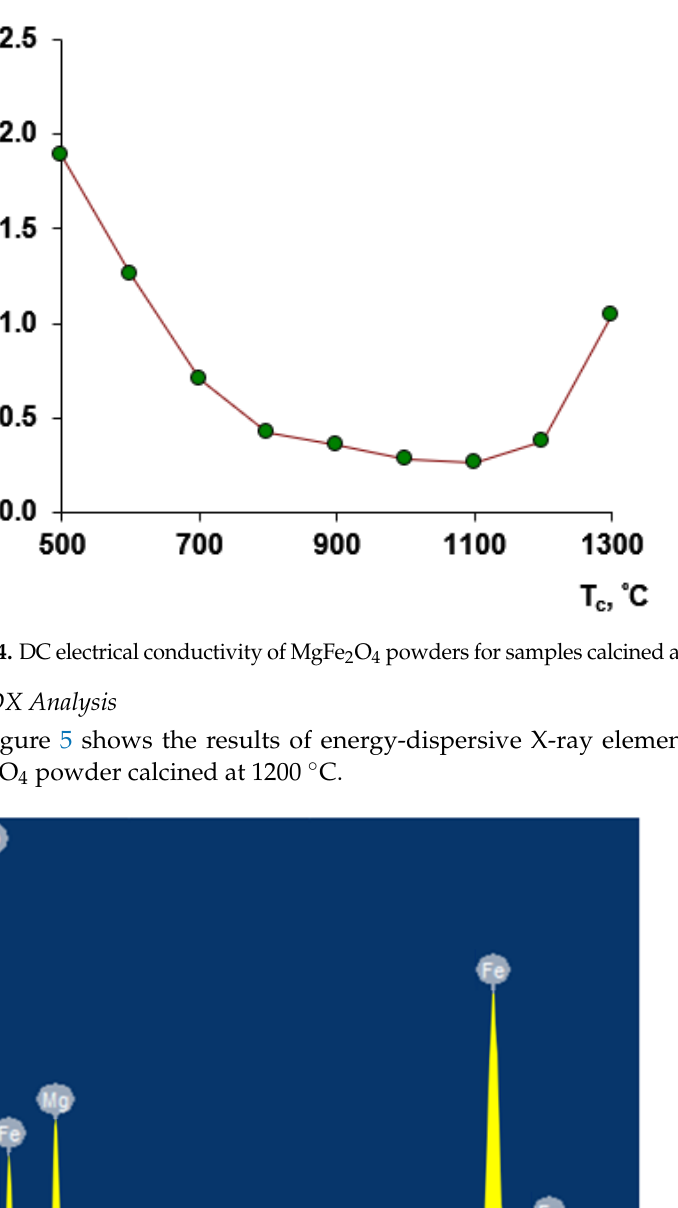
Figure 6. The complex permeability, complex permittivity, magnetic loss and dielectric loss tangent of MgFe 2 O 4 –paraffin composite.